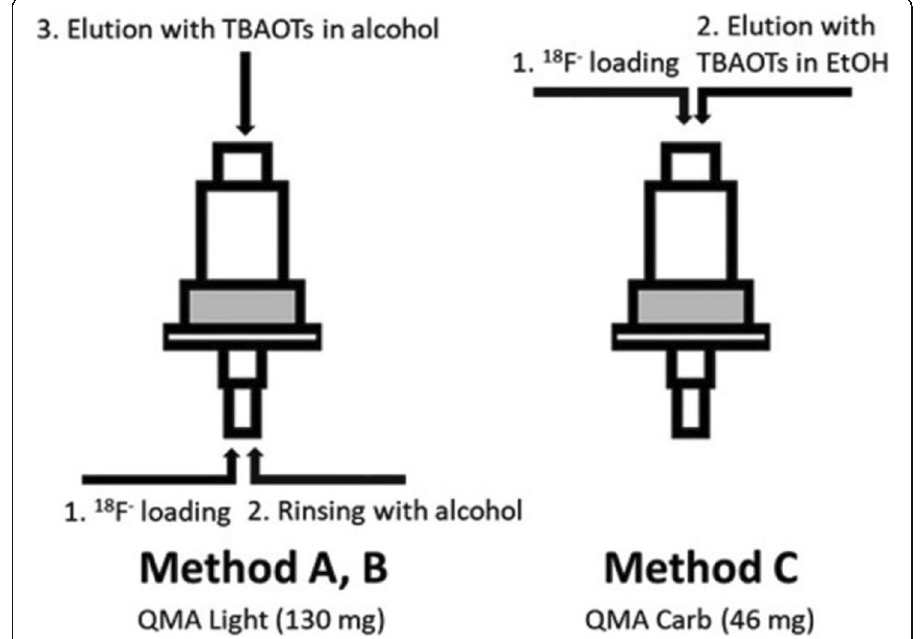
Fig. 3 The schematic presentation of loading-elution protocols used in this study. (With permission